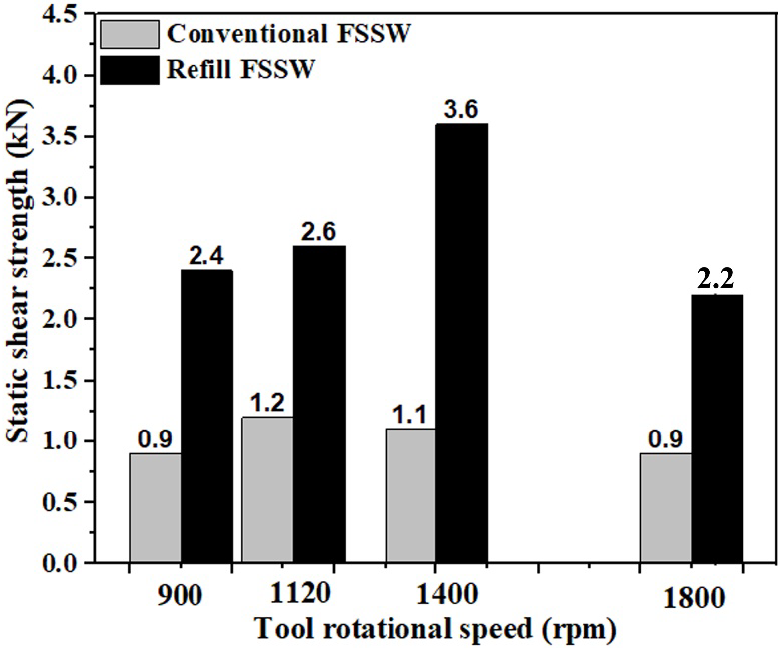
Figure 14. Static shear strength of dissimilar welds made by the C-FSSW and R-FSSW.